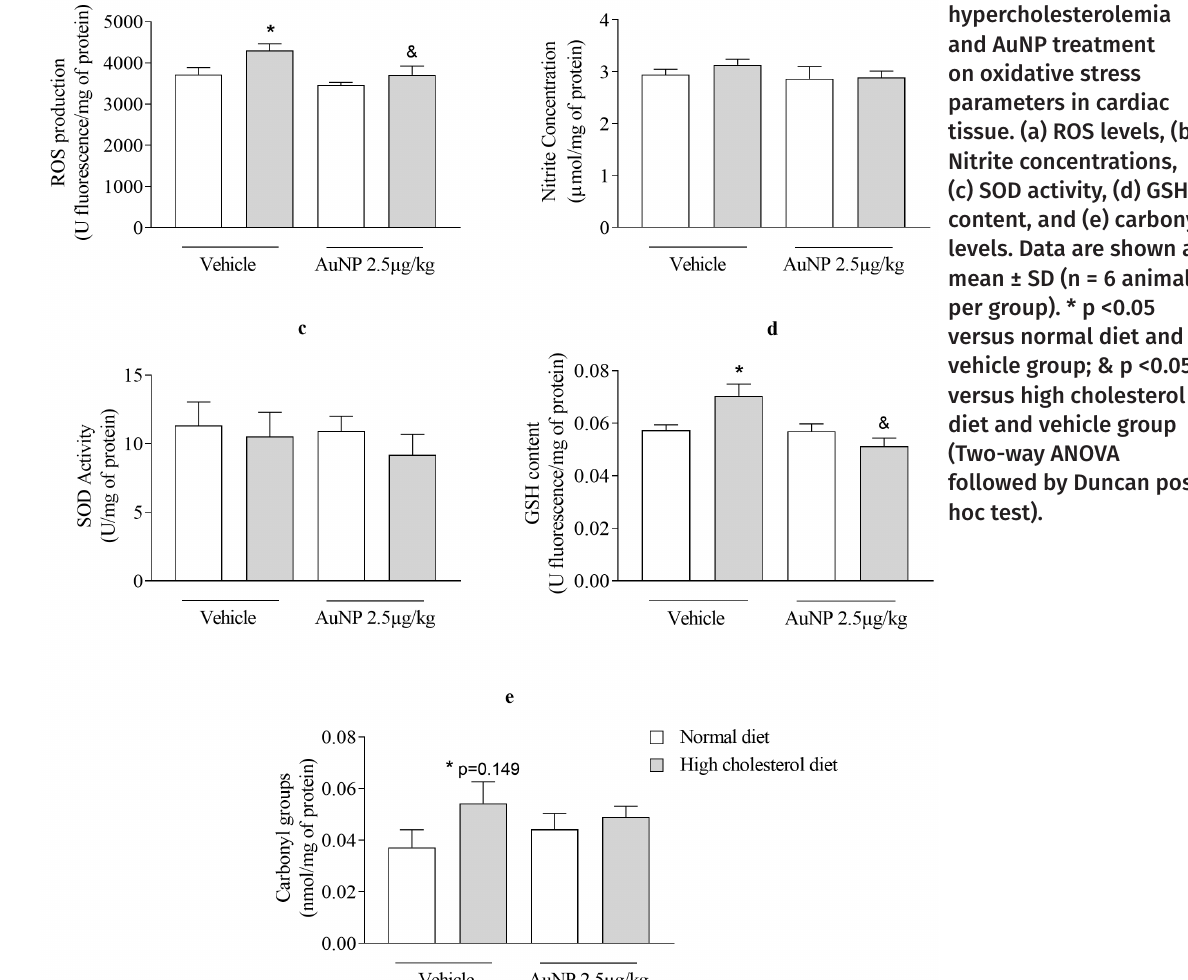
Figure 3. Effects